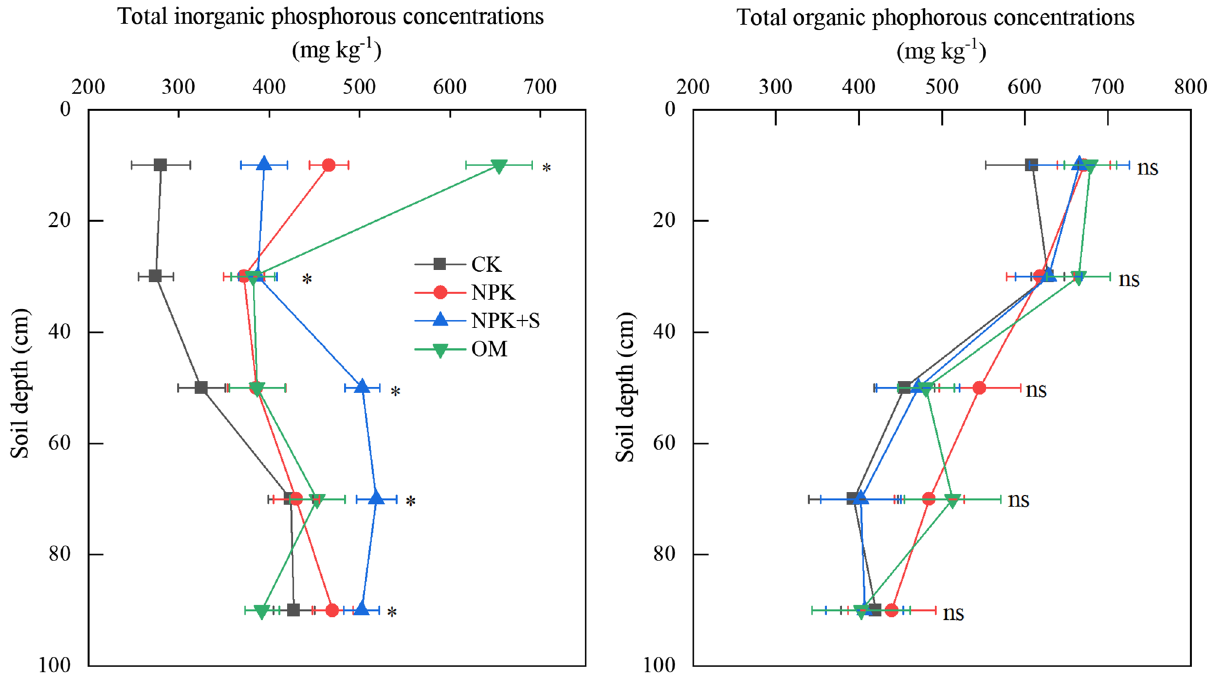
Figure 4. Effect of long-term application of chemical fertilizer, organic manure and straw on the distribution of organic-P and inorganic-P contents. * indicates significant difference at P < 0.05 level at the same soil depth, ns indicates no significant difference regarding the total inorganic and organic P concentrations at the same soil depth. CK, no fertilizer application; NPK, chemical fertilizer application; NPK + S, chemical fertilizer plus maize straw incorporation; OM, organic manure